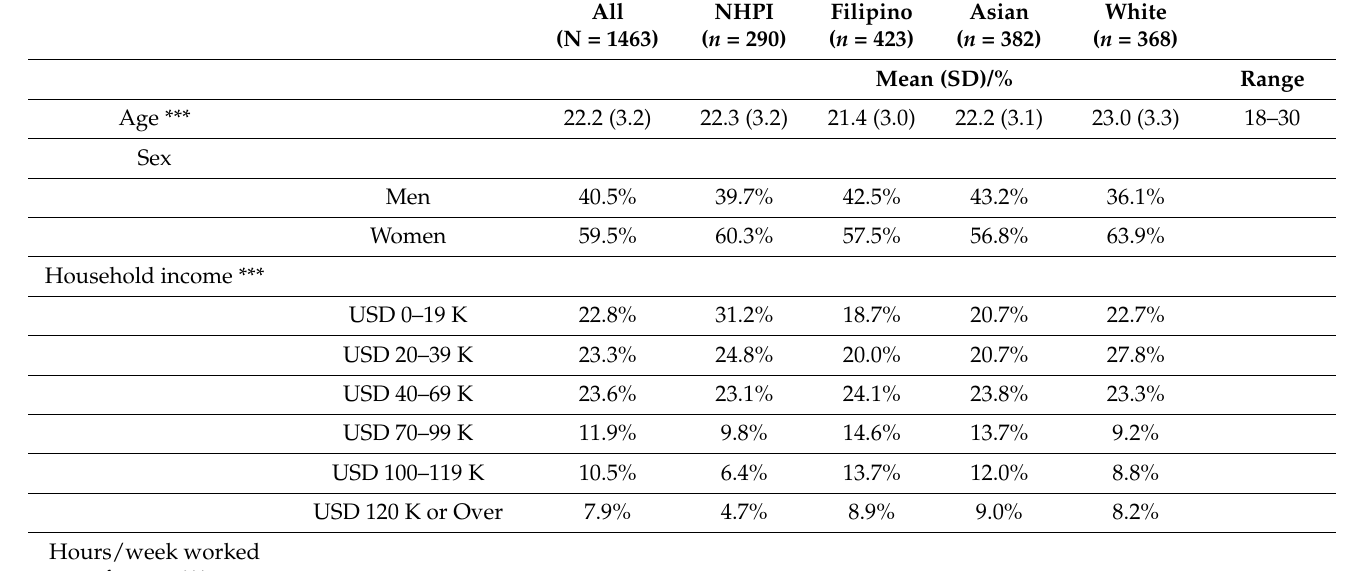
Table 1. Baseline participant characteristics by